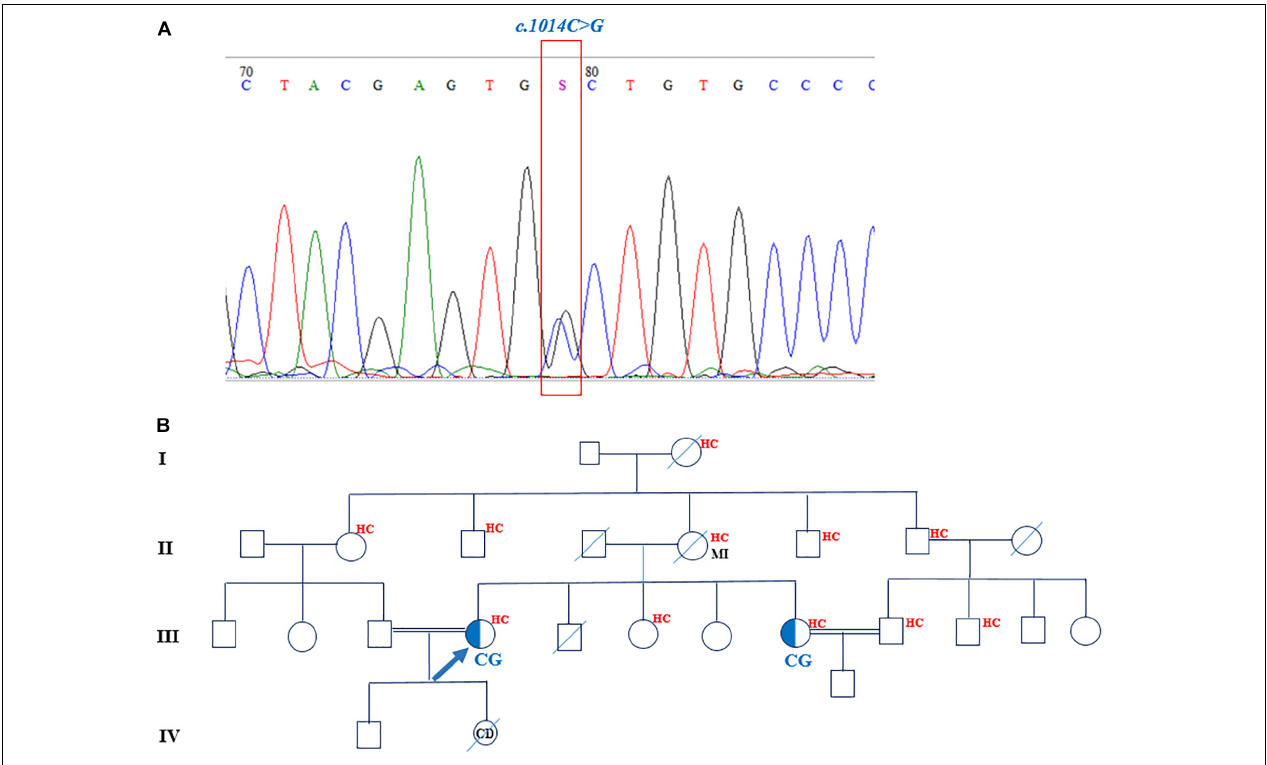
FIGURE 3 | The chromatogram and pedigree of patient carried the novel mutation in LDLR gene. (A) The identified c.1014C > G nucleotide change shown in a chromatogram. (B) The pedigree of proband demonstrated the positive family history of hypercholesterolemia and myocardial infarction. The sister of proband is also heterozygote for the mutation. MI, myocardial infarction; HC,